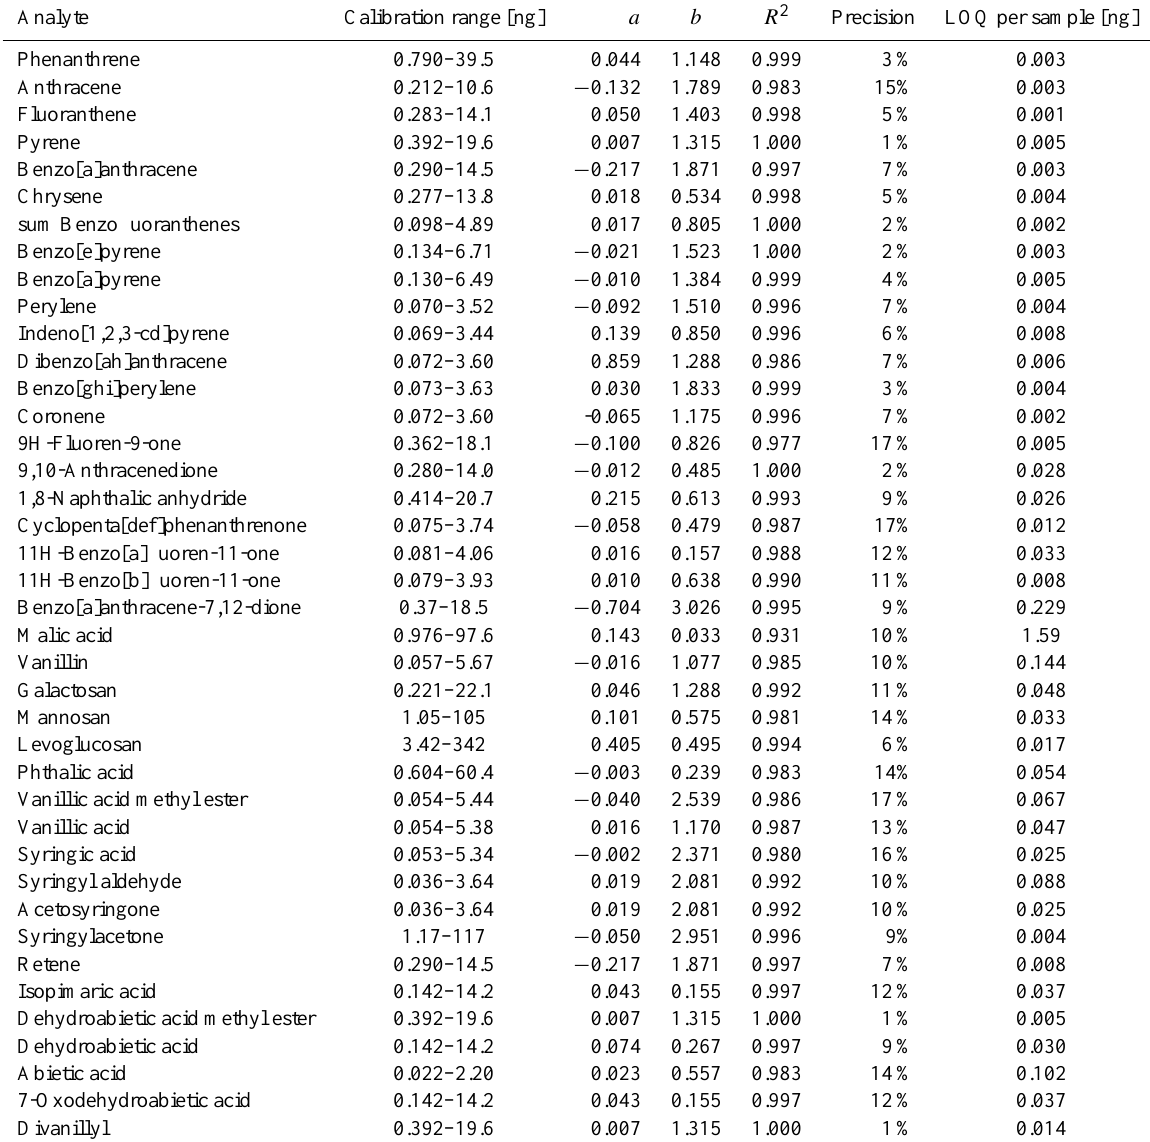
Table 1. Validation parameters obtained from the calibration curves of IDTD-GC-TOF MS. Calibration range means lowest and highest standard concentrations used for the calibration curve; a =interception, b =slope (area ratio/mass ratio). The limit of quantification (LOQ) of the method is defined as the minimum amount of substance that is according to the minimum reliable signal plus nine times (three times for LOD) the standard deviation of this underground signal. The complementary information of SE-GC-TOFMS can be found in the supplementary information (Table